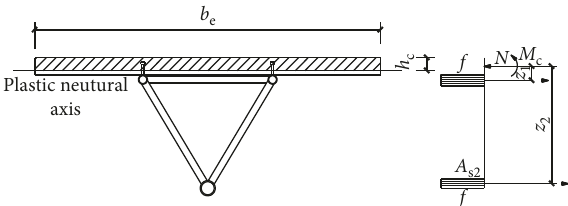
Figure 20: Sketches of the composite truss with the plastic neutral axis in the concrete